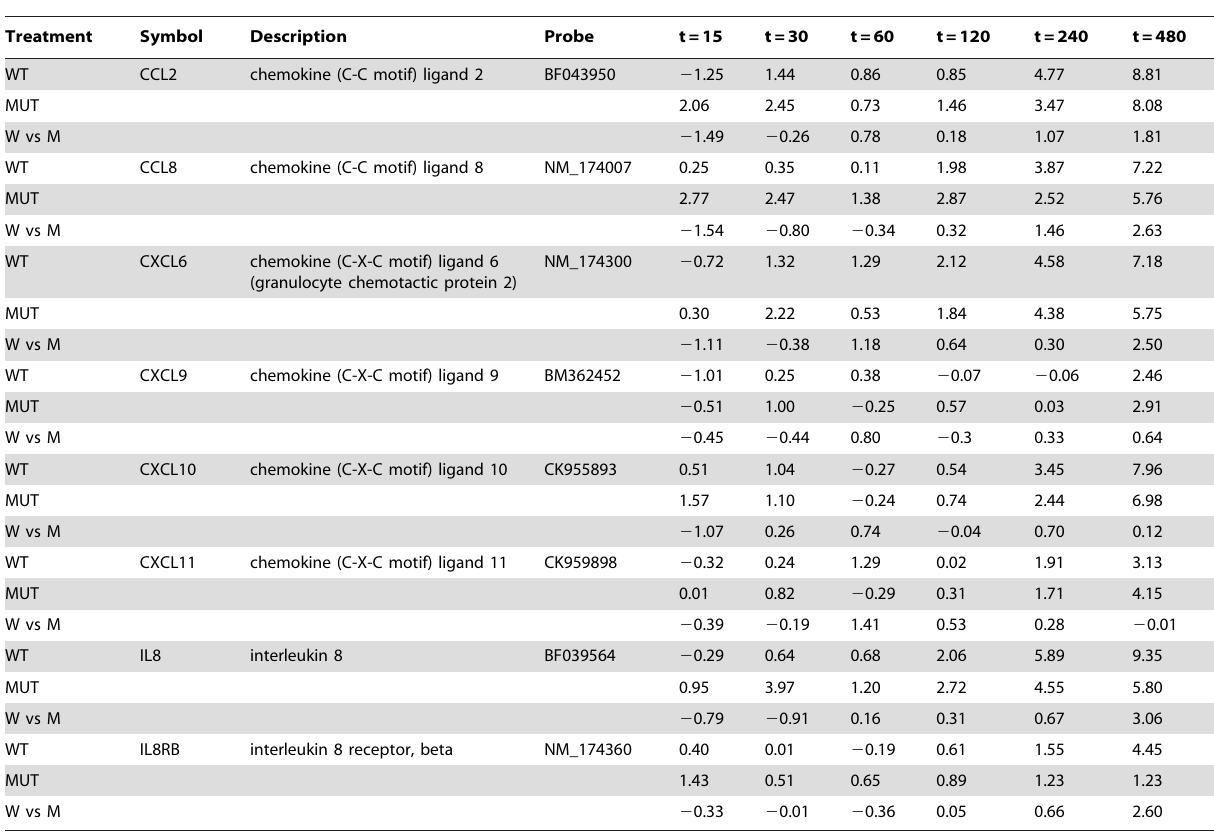
Table 5. Chemokine gene expression z -score.